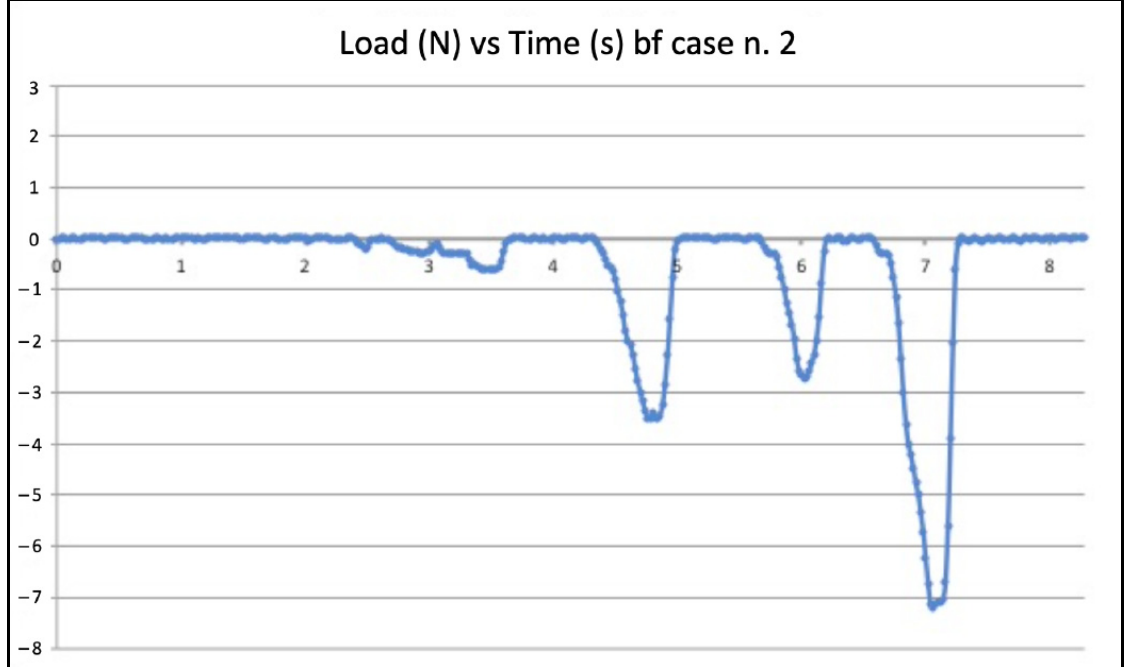
Figure 4. Graphic plot of the simulation on model n. 5 (successful watch winding motion negotiation).